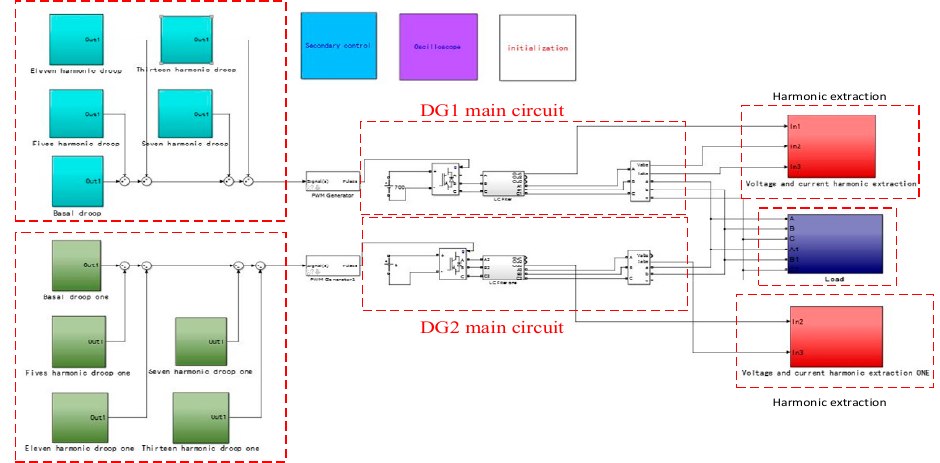
Figure 10. The simulation model in MATLAB2014B.